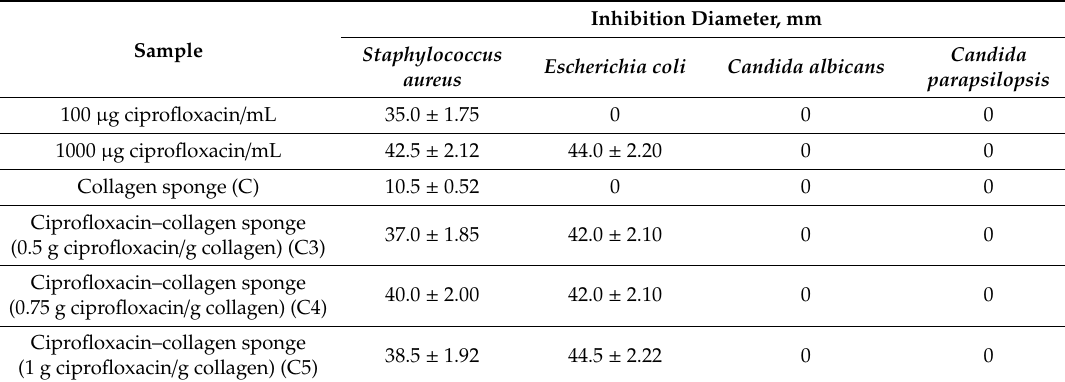
Table 2. Inhibition diameter of the tested sponges against di ff erent